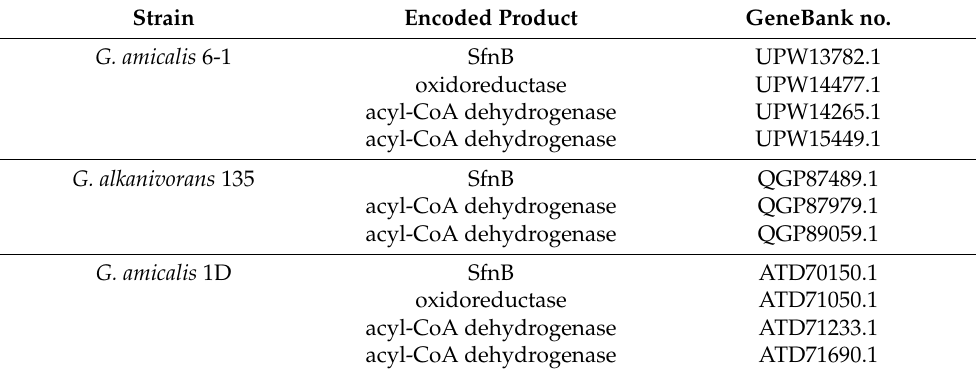
Table 2. Gene products annotated as